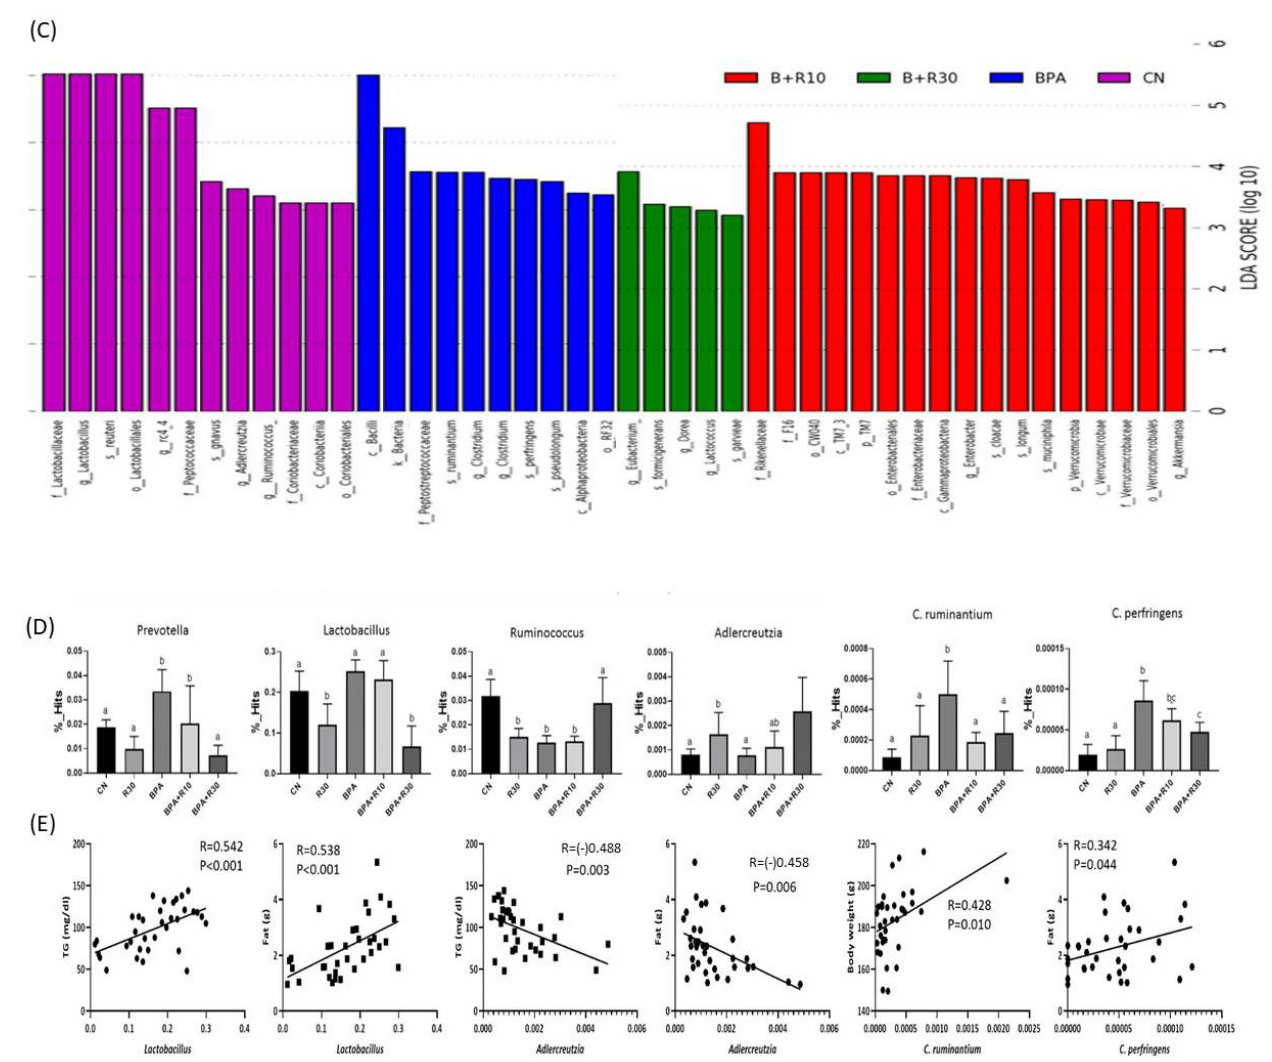
Figure 3. Effects of BPA and RBE on the gut microbiota of female offspring rats. ( A ) The gut bacterial composition at the phylum level. ( B , C ) Biomarker taxons generated from the LEfSe analysis (LDA > 3). ( D ) Comparison of the growth and decline of specific strains with significant changes in the OTU and LEfSe analyses. ( E ) Correlation analysis. a,b Values with different letters are specific to each group and show significant differences ( p < 0.05). CN = control group; R30 = group administered with 30 mg/kg/day of RBE; BPA = group administered with 50 μg/kg/day of bisphenol A; BPA+R10 = group administered with 10 mg/kg/day of RBE and bisphenol A; BPA+R30 = group administered with 30 mg/kg/day of RBE and bisphenol A. Data are expressed as means ± SD ( n = 4–8).